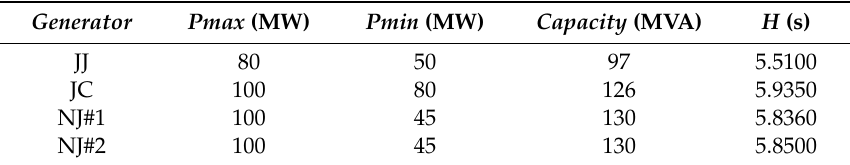
Table 5. Parameters of the RMR